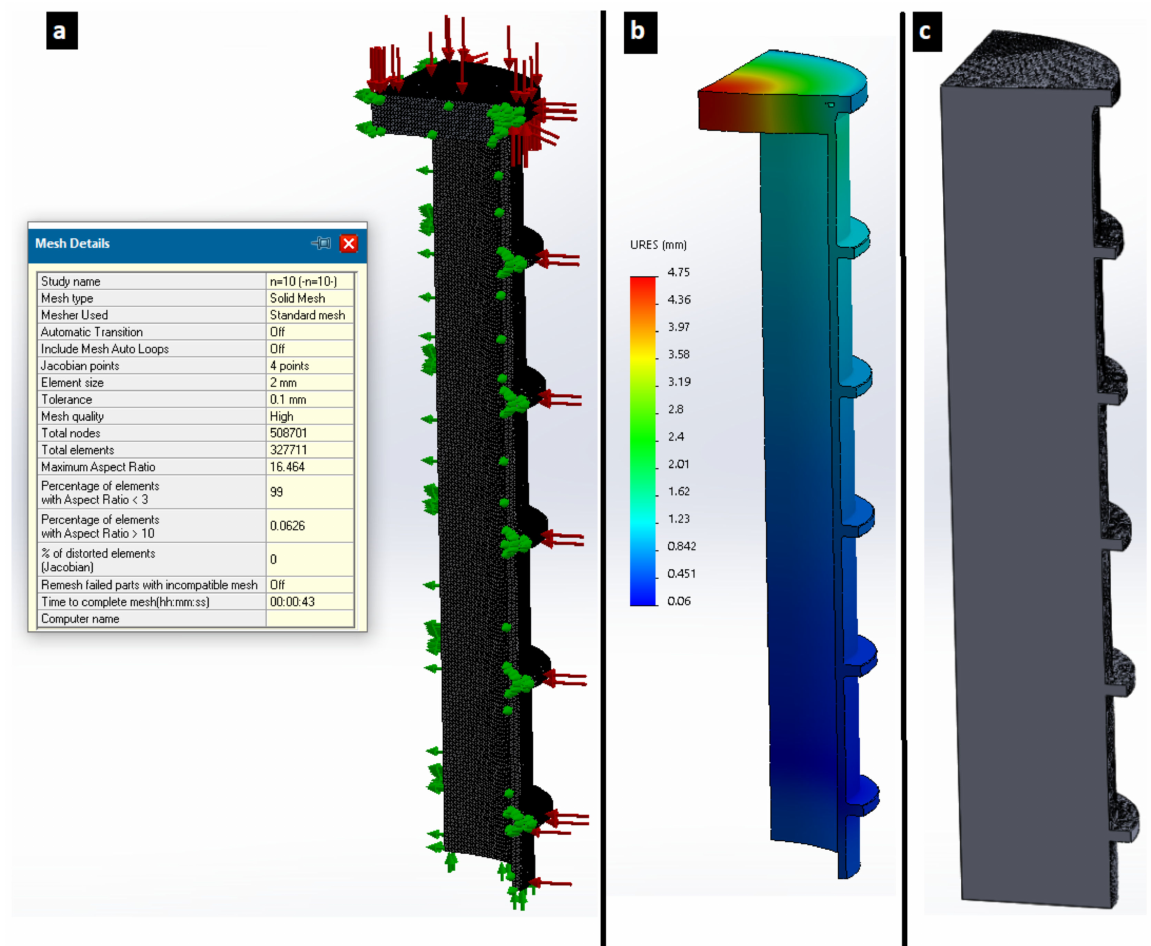
Figure 11. Stiffened cylinder compressibility FEA: ( a ) mesh, loads, boundary conditions and mesh de- tails; ( b ) static analysis total displacement; ( c ) deformed body shape employed in volume computation.